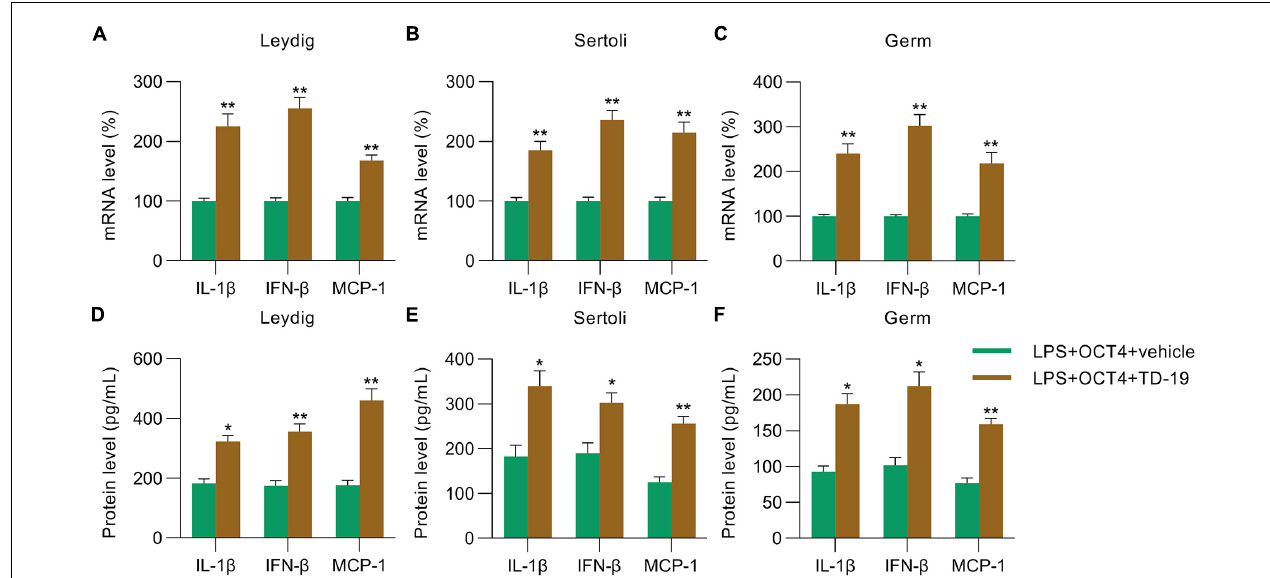
FIGURE 6 | Effects of TD-19 administration on inflammation in OCT4-overexpressing and LPS-induced Sertoli, Leydig, and germ cells. Leydig, Sertoli, and germ cells were transfected with pcDNA3-OCT4 or pcDNA3-NC and then incubated with LPS and TD-19 for 12 h. (A–C) Total RNA was extracted from the cells, and the relative mRNA levels of IL-1 β , IFN- β , and MCP-1 in the cells were determined using RT-qPCR. (D–F) ELISA was conducted to examine the secreted IL-1 β , IFN- β , and MCP-1 levels in the cells. Data are expressed as the means ± SDs. * P < 0.05, ** P < 0.01, LPS + OCT4 + vehicle vs. LPS + OCT4 +